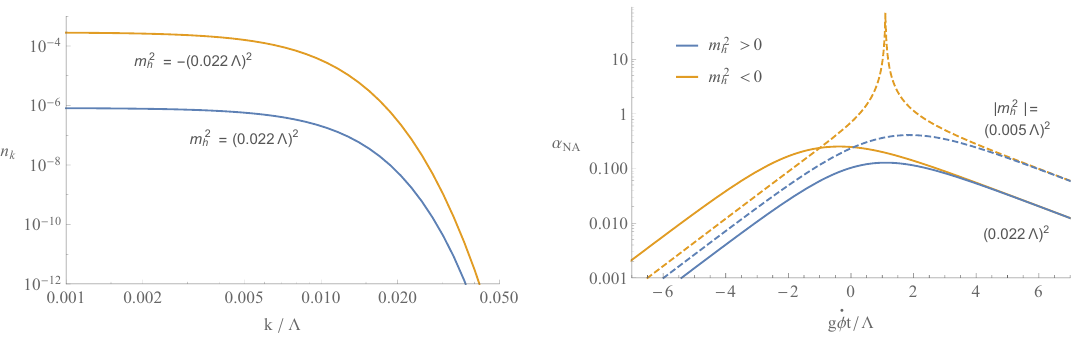
Figure 1 . Left: the occupation number n k of Higgs modes with momentum k produced during reheating, for sectors in which the in(cid:13)aton independent components of the Higgs mass squared pa- rameters are m 2 = (0 : 022(cid:3)) 2 and m 2 = (cid:0) (0 : 022(cid:3)) 2 . The in(cid:13)aton couplings are given by eq. (3.4), p h h with g = 0 : 02 and a constant speed _ (cid:30) = (cid:3) 2 = 8. A partial cancellation in the total Higgs mass while _ (cid:30)t . 0 in the negative Higgs mass squared case leads to more e(cid:14)cient production of low momentum (cid:0)(cid:12) (cid:12) (cid:1) modes. Right: the value of the non-adiabaticity measure (cid:11) NA = _ m int = as a func- (cid:12) m 2 h + m 2 int (cid:12) + k 2 tion of time, where m 2 is the in(cid:13)aton dependent component of the Higgs mass squared parameter, int for a mode with momentum k = 0 : 001(cid:3). The results are shown for sectors with di(cid:11)erent Higgs mass squared parameters, and the in(cid:13)aton couplings are as in the left panel. For m 2 = (cid:0) (0 : 022(cid:3)) 2 h the physical Higgs mass is small over a large time range _ (cid:30)t . 0, and production is more e(cid:14)cient than for m 2 = (0 : 022(cid:3)) 2 . For m 2 = (cid:0) (0 : 005(cid:3)) 2 there is a moment when the physical Higgs mass h h vanishes, leading to more energy transfer than for m 2 = (0 : 005(cid:3)) 2 h